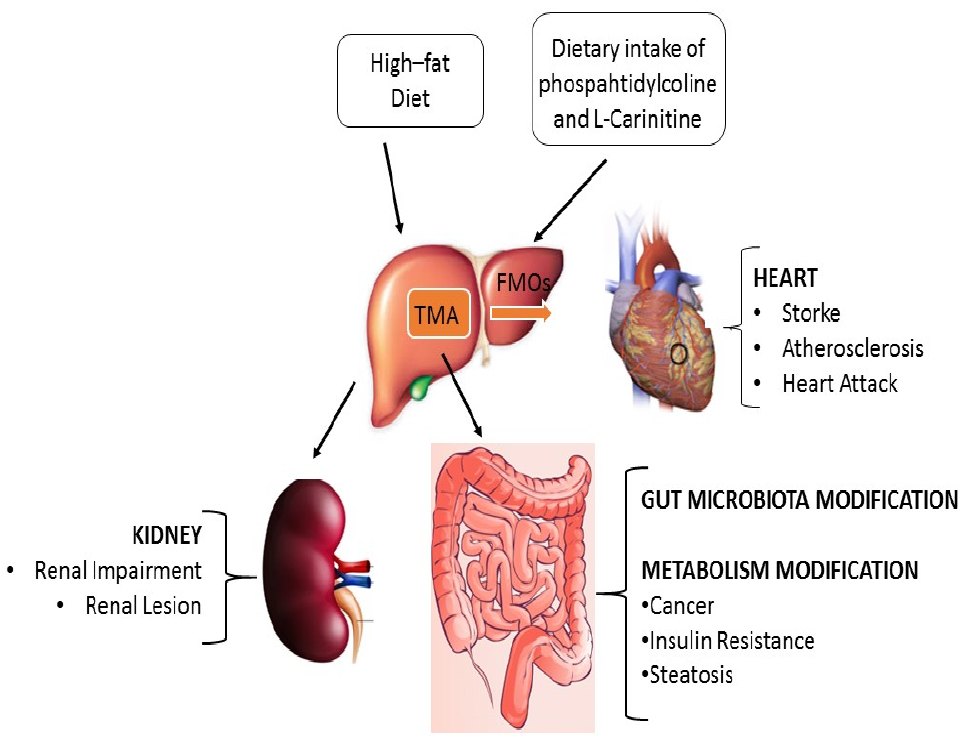
Figure 1. The action of TMA in pathological condition. The dietary intake of choline isoforms, carnitine, gamma ‐ butyrobetaine contribute to increment the plasma level of TMA. TMA are converted in TMAO in the liver. TMAO are involved and correlated with kidney and liver disease, gastrointestinal cancers, diabetes type II, atherosclerosis, and cardiac muscle damage. Table 2. L ‐ carnitine raw food contents in mg for 100 g [2].